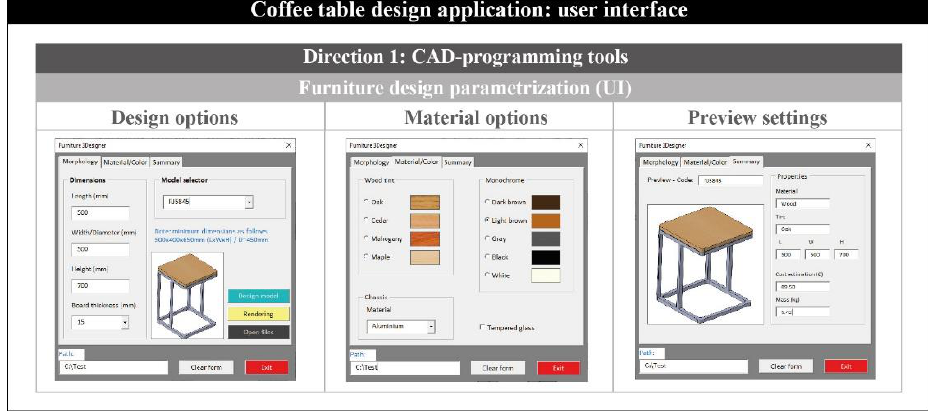
Figure 2. The three tabs of the coffee table design